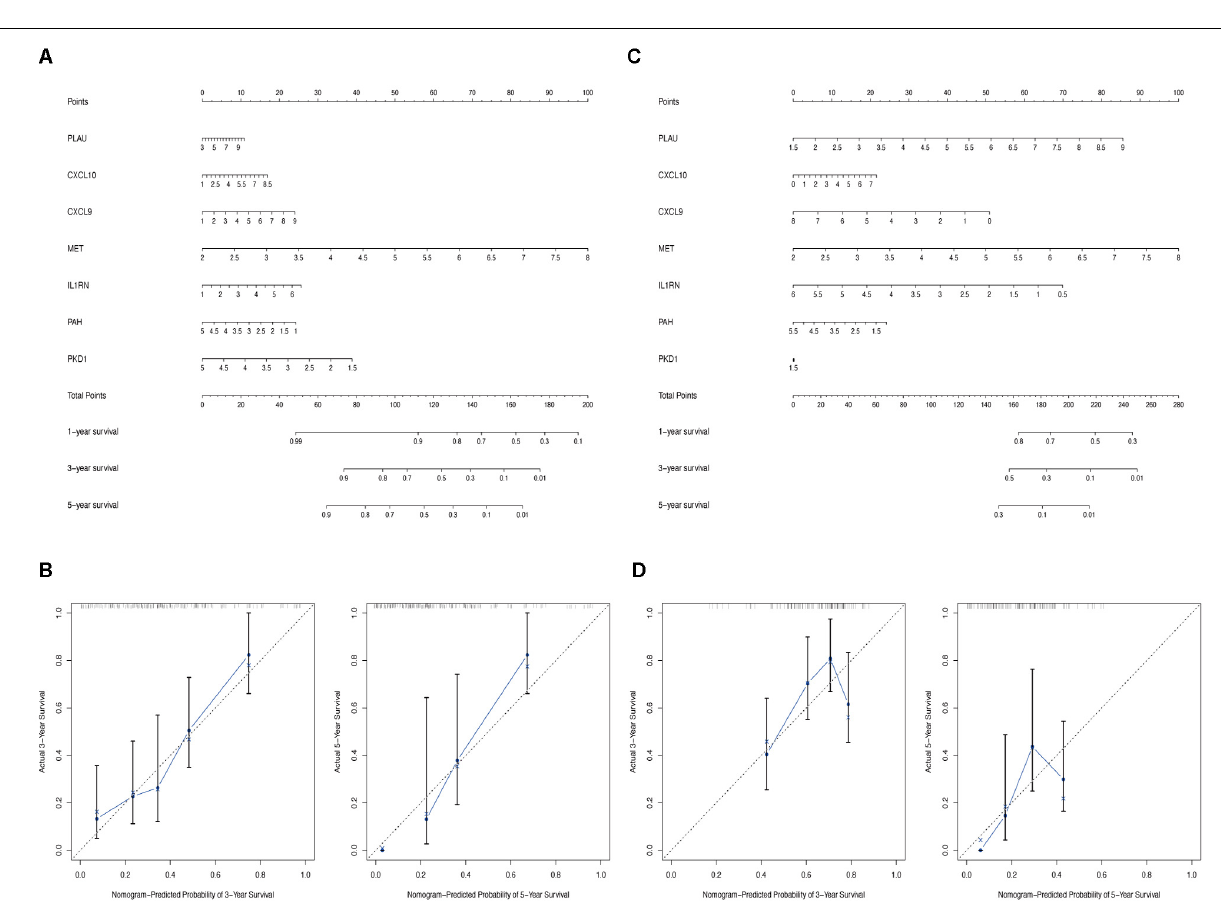
Frontiers in Genetics |